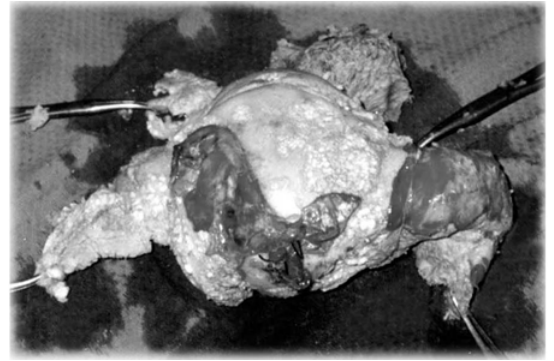
FIGURE 3. Showing the specimen (fetus-in-fetu) in dorsal view, forceps pointing to four limbs